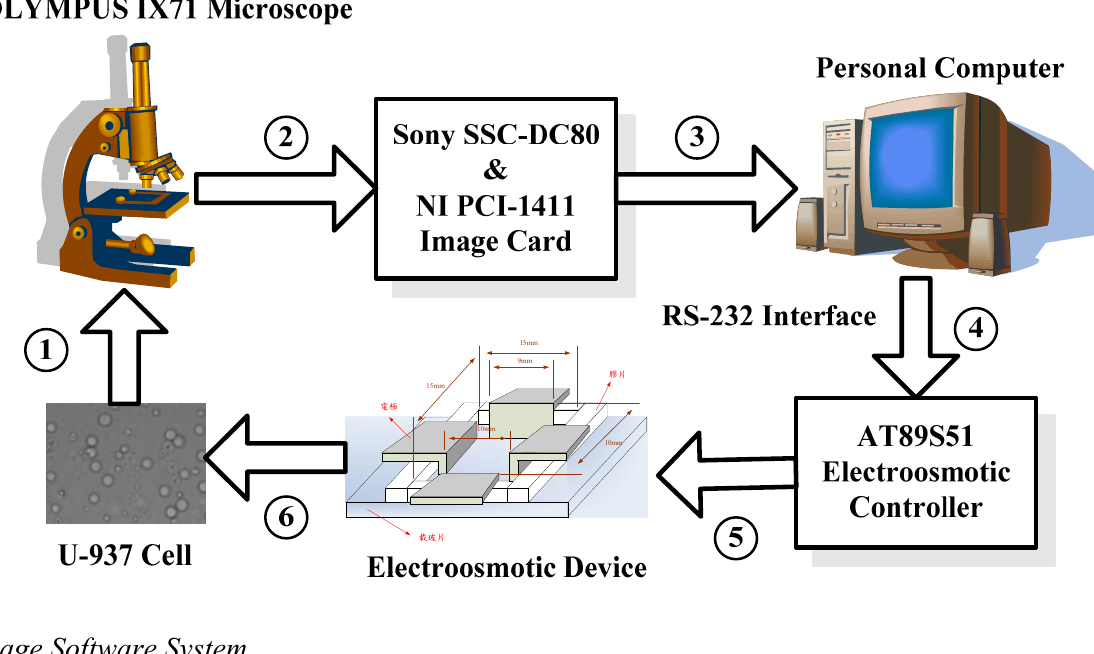
Figure 1. Schematic block in the present